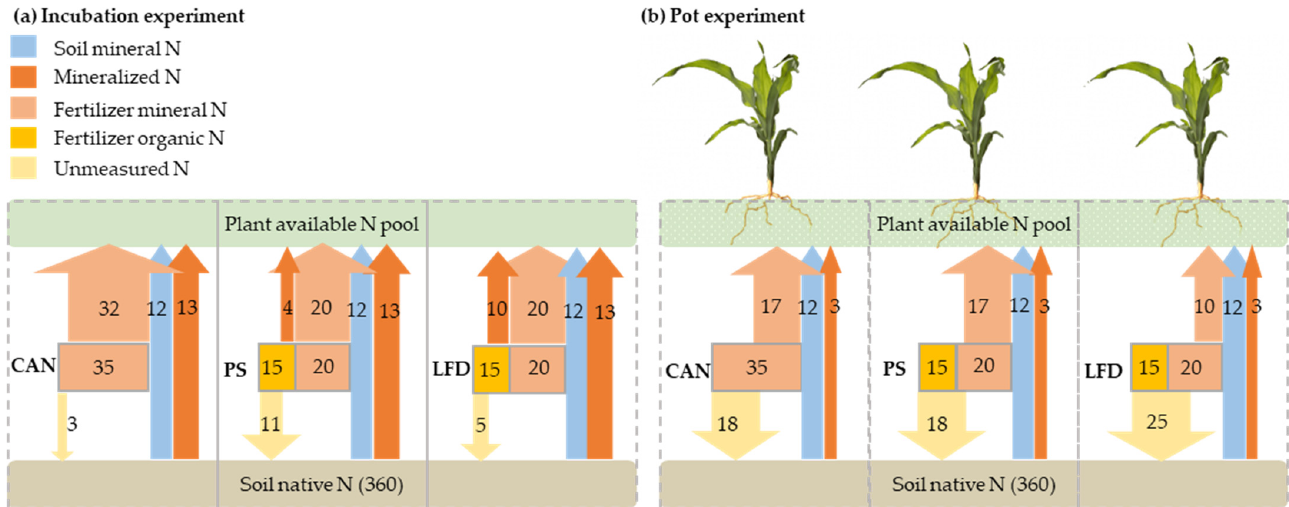
Figure 5. Mass balance of N flow in incubation experiment ( a ) and maize-growing pot experiment ( b ) on day 100. The numbers represent the mean value of N concentration (mg N kg − 1 soil dry weight (DW)). The soil native N was measured as 360 mg N kg − 1 soil DW. The soil mineral N was the mineral N in soil before fertilization, while the mineralized N from soil was calculated from the difference of mineral N content in control and fertilizer treatments between day 100 and day 0. CAN = calcium ammonium nitrate, PS = pig slurry, LFD = liquid fraction of digestate.